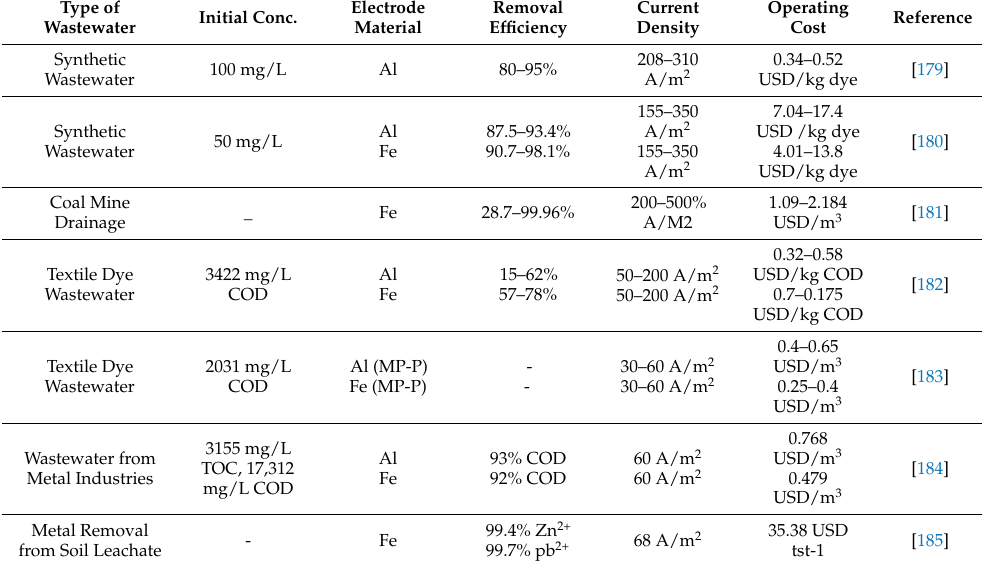
Table 6. Few EC based studies indicating operation cost in different